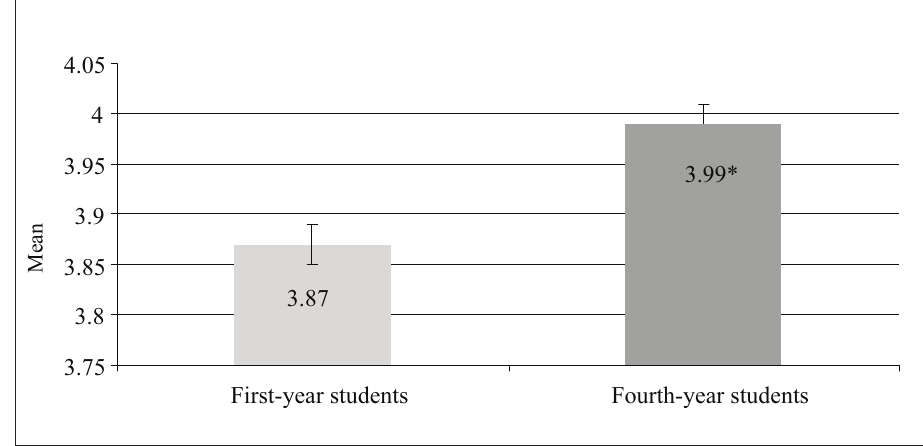
Figure. Mean scores of the level of career self-